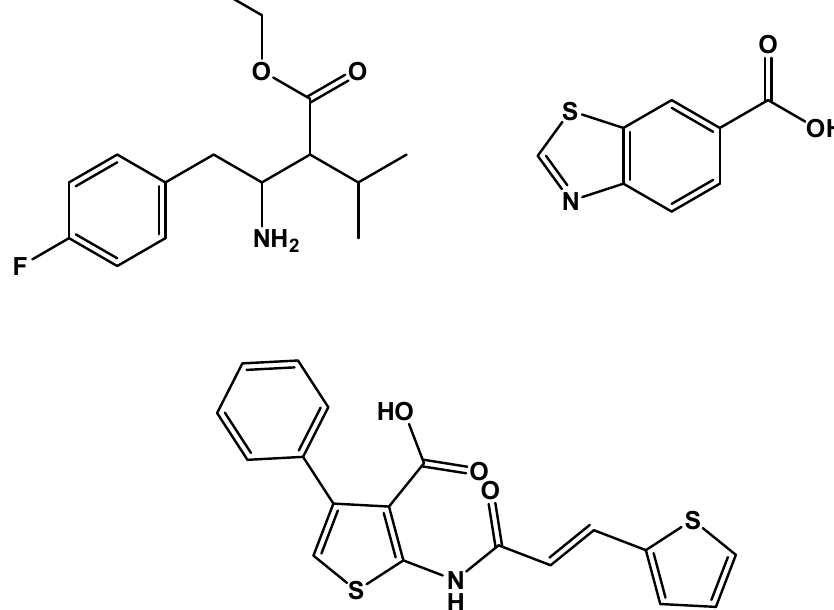
Figure 8. Some of the inhibitors uncovered by the FRET assay performed by Walker et al. [29].